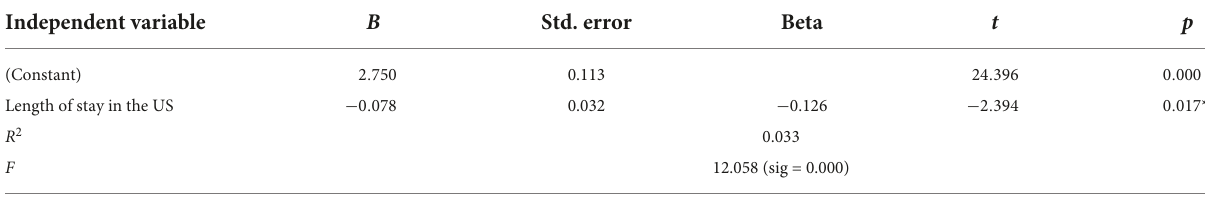
TABLE 4 Regression test of the length of stay in the US on intercultural adaptation stress. Independent variable